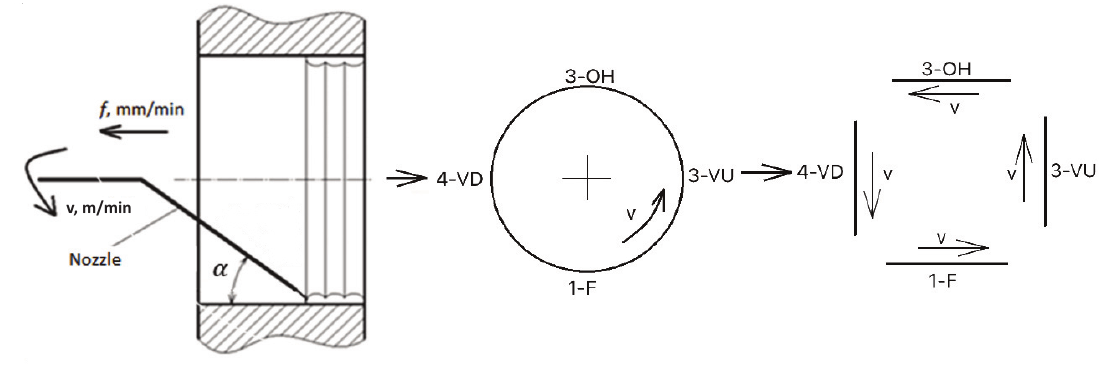
Fig. 2. Laser cladding experiment scheme.